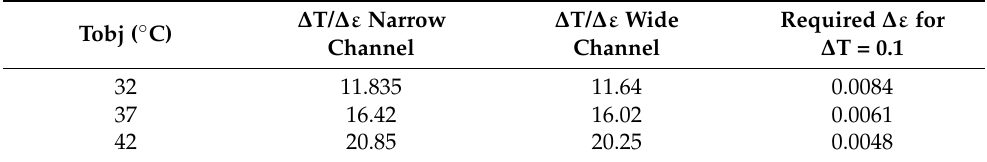
Table A1. Relation between temperature inaccuracy to emissivity inaccuracy of narrow and wide filters optical